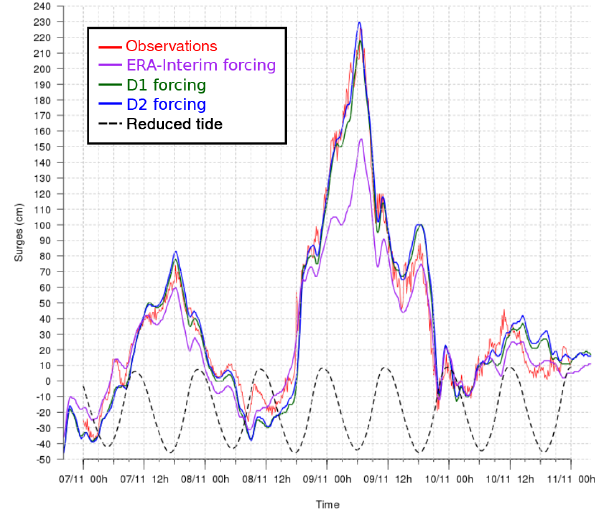
Figure 10. Storm surges (centimetres) at Dunkirk from 7 November 2007 at 15:00UTC to 11 November 2007 at 06:00UTC. The mea- sured surge (red), the reconstructed surge by using the ERA-Interim forcing (purple), the D1 forcing (green) and the D2 forcing (blue) are superimposed. The oscillatory dotted line in the lower part of the graph is used to indicate the time of high and low